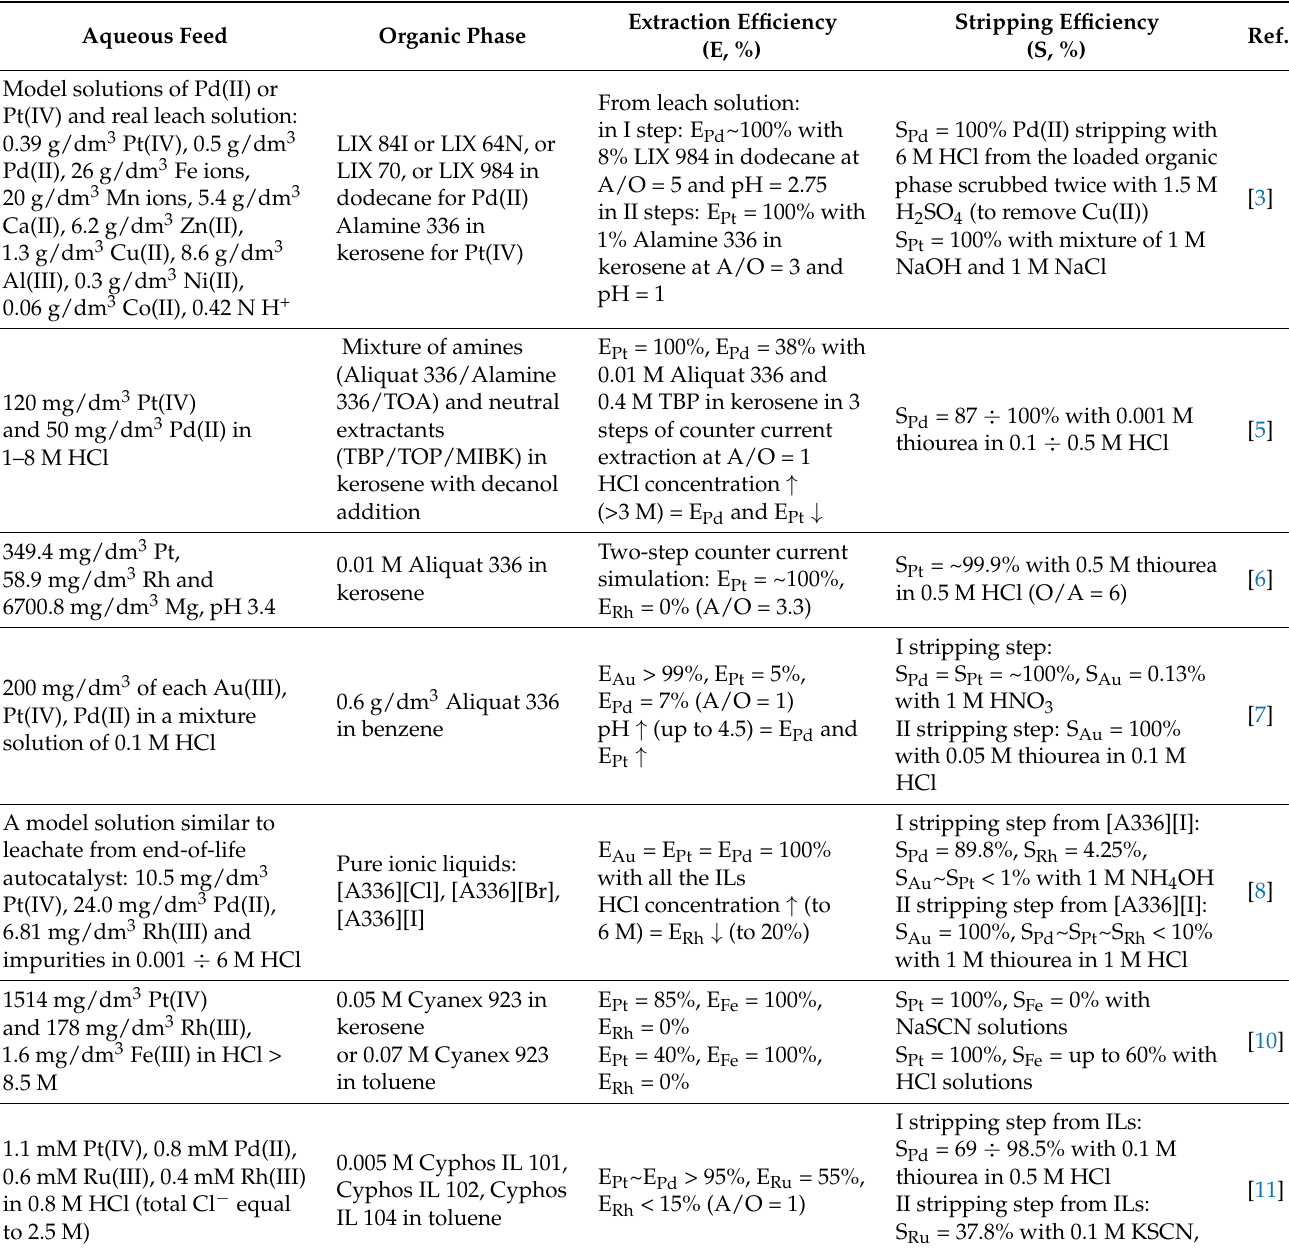
Table 1. Comparison of various Pd(II) and Pt(IV) extraction